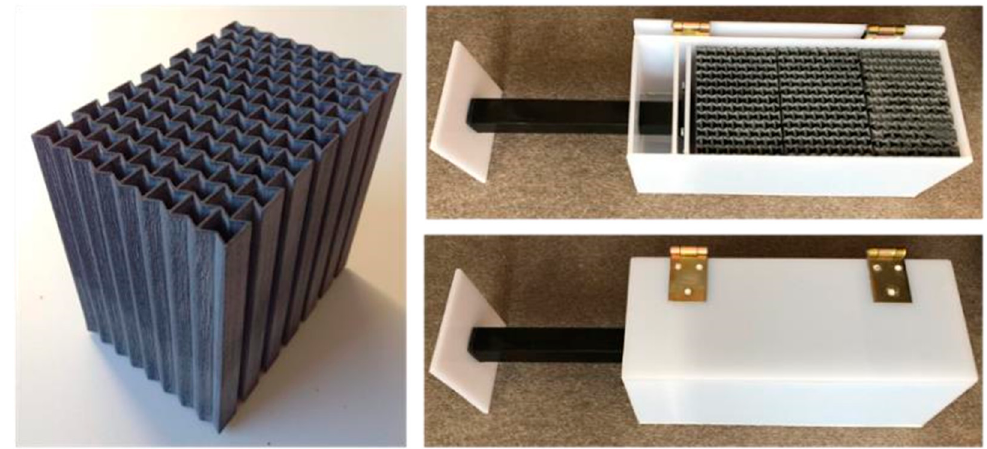
Figure 26. A three dimensional (3D) printed prototype of the UGAD.